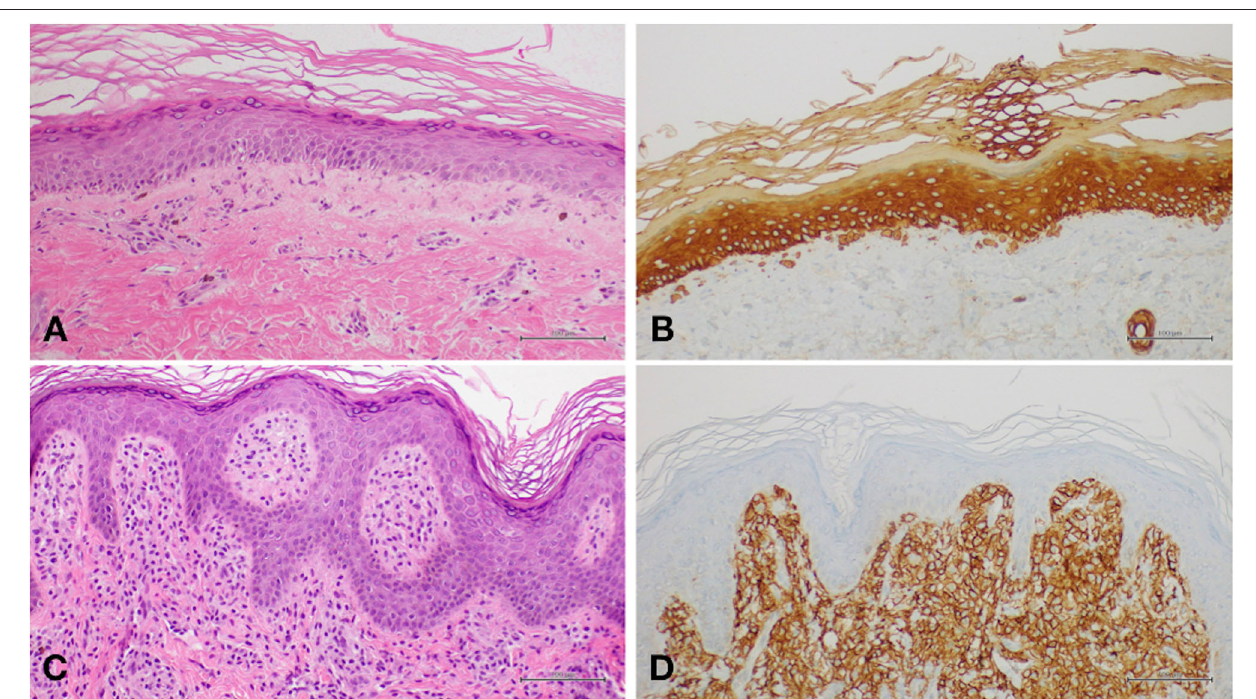
FIGURE 3 | (A) Histology of poikiloderma showing slightly atrophic and flattened epidermis, focal images of hydropic degeneration of the basal layer, light perivascular lymphohistiocytic infiltrate, and pigmentary incontinence. (B) Several Civatte bodies highlighted by high molecular weight cytokeratin (HMW-CK) immunostaining. (C) In mastocytoma, histological examination showed a dense cellular infiltrate occupying the superficial dermis. The cells were characterized by moderately abundant, amphophilic, and finely granular cytoplasm and oval-shaped nuclei with clumped chromatin. (D) Immunohistochemical investigation showing positivity for CD117